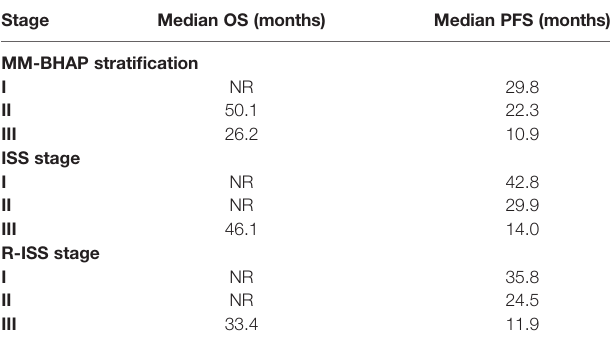
TABLE 4 | Comparison of OS and PFS duration by stage in the development cohort. Stage